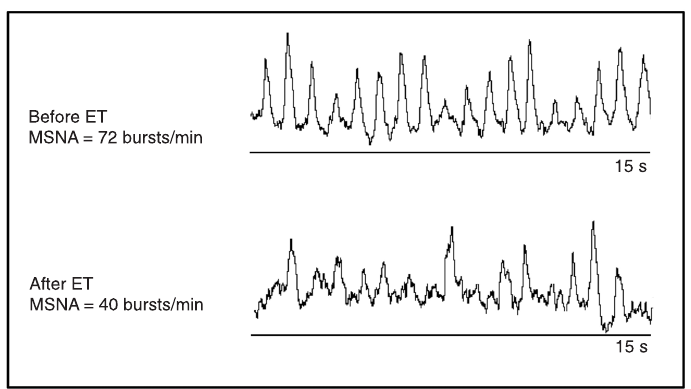
Figure 1. Muscle sympathetic nerve activity (MSNA) of a 58-year-old female heart failure patient (hypertensive cardiomyopathy) with a 36% ejection fraction before and after 4 months of exercise training (ET). MSNA was obtained by direct recording of muscle sympathetic discharge by microneurography. Note that exercise training dramatically reduced sympathetic